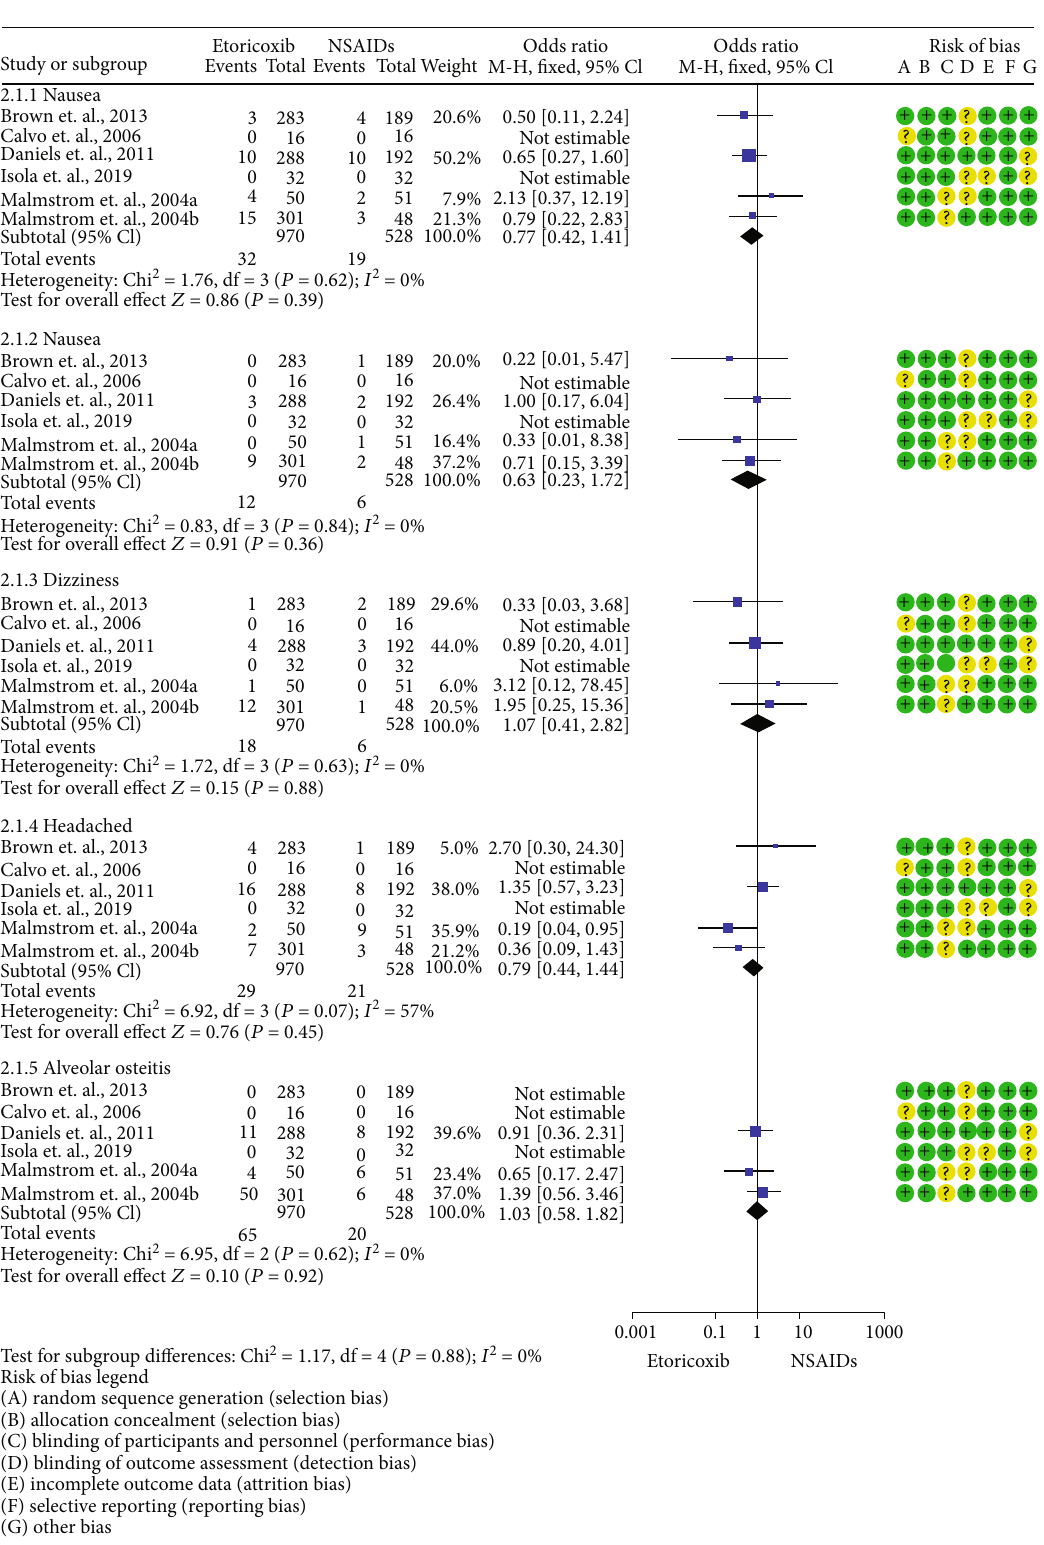
Figure 7: Forest plot of adverse e ff ects associated with etoricoxib and